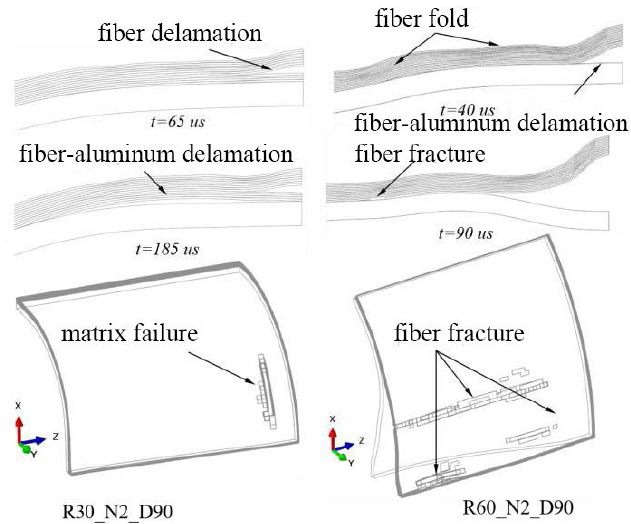
Figure 14. Failure mode of the fiber layer with a small radius of curvature.